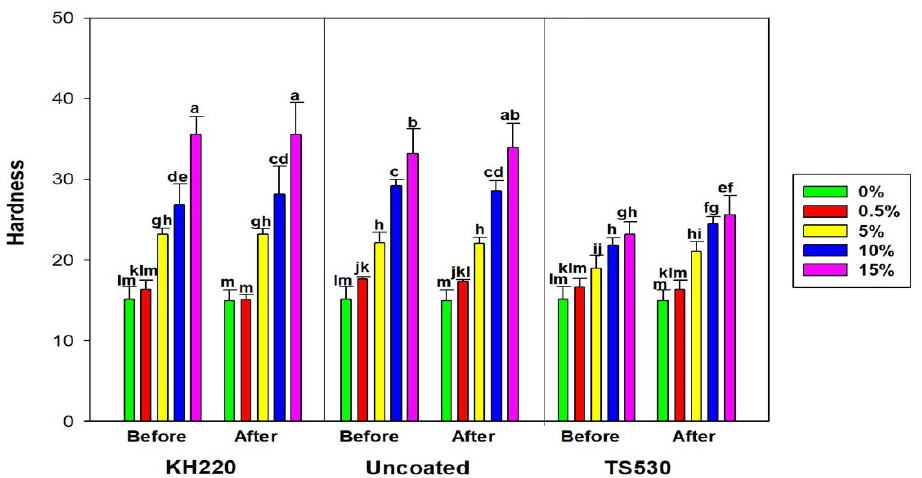
Figure 13. Bar graph displaying means and error bars representing standard errors of means for Durometer Hardness for Outdoor samples before and after 3000 h of weathering. Lower case letters denote statistical groupings. Groups with means having the same lower-case letters are not significantly different ( p > 0.05, ANOVA/Tukey). Comparisons are both within and across materials.